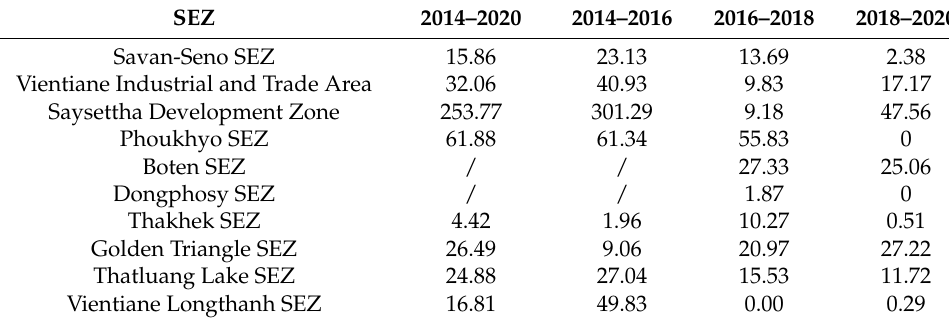
Table 1. Comprehensive land-use dynamic degree in Laos’ SEZs (unit: %).